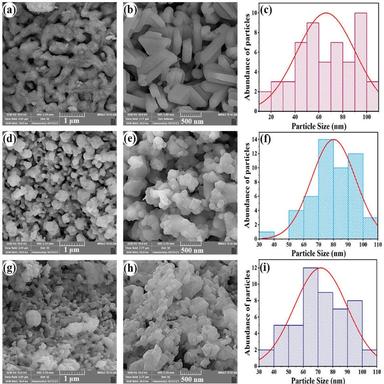
FE-SEM images and particle size distribution of (a–c): S5, (d, f): S6 and (g, i): S7.